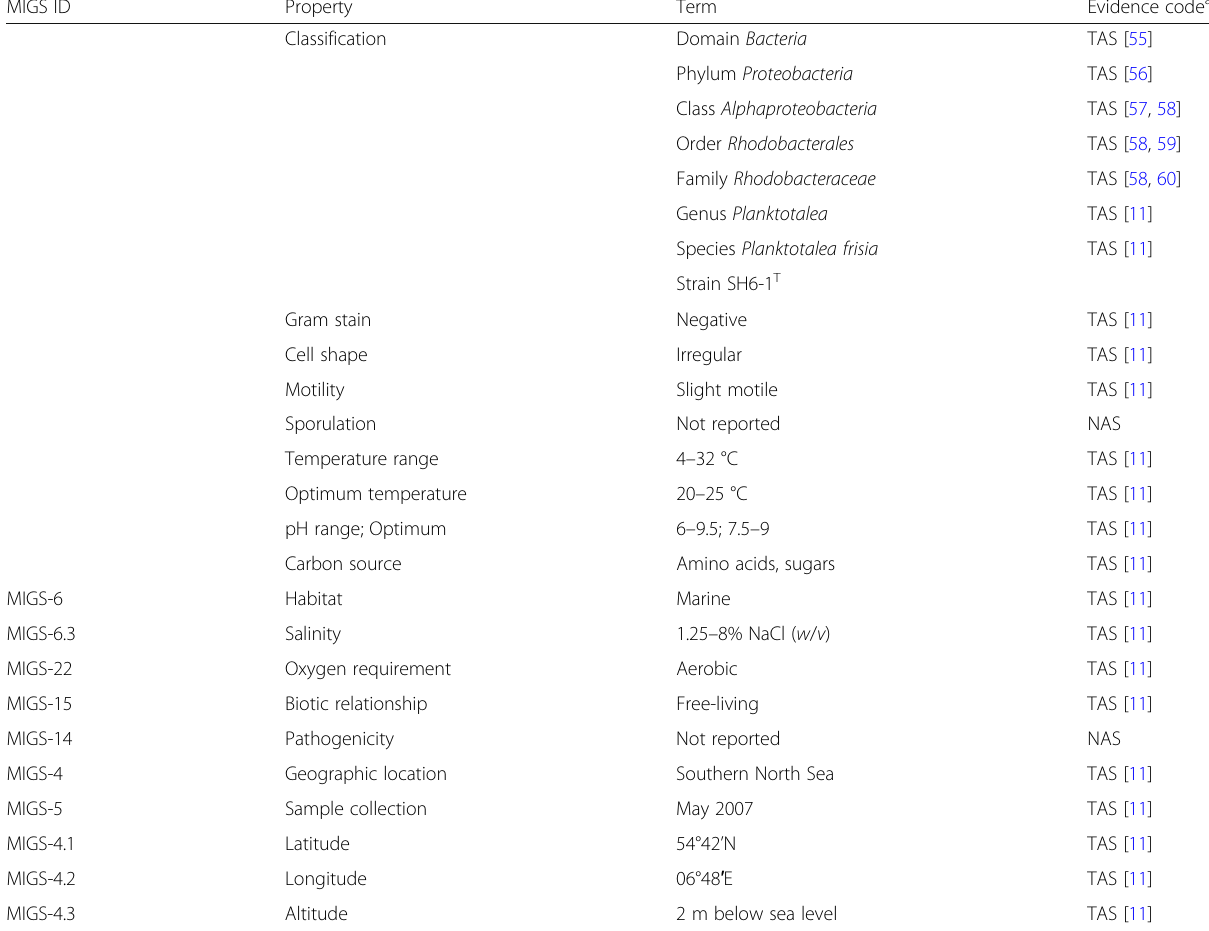
Table 1 Classification and general features of Planktotalea frisia SH6-1 T according to the MIGS recommendations [53] published by the Genome Standards Consortium [54]